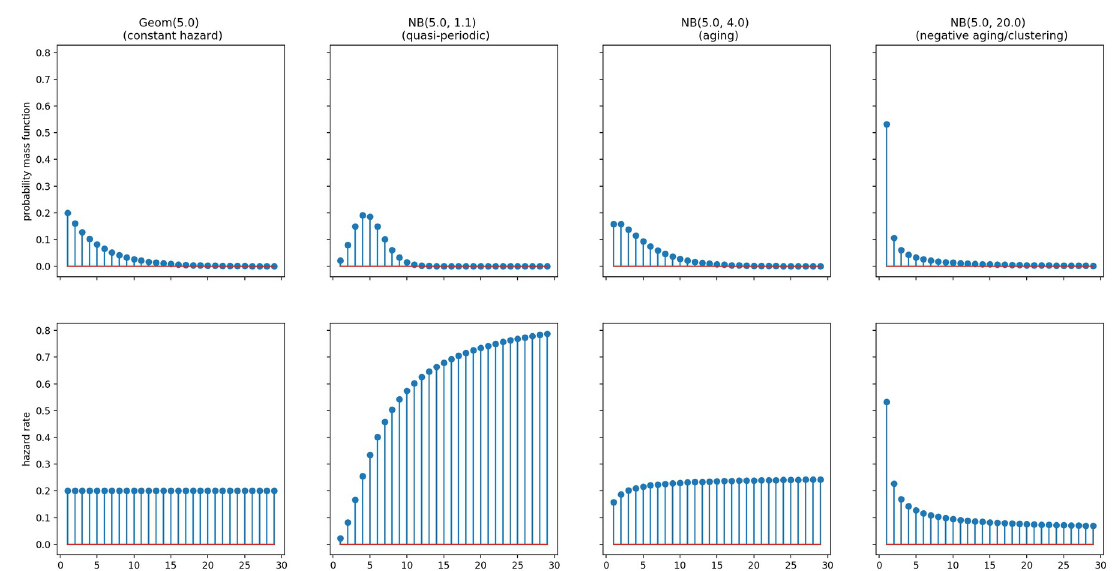
Fig 1. Comparing probability mass functions and hazard rates of geometric and negative binomial